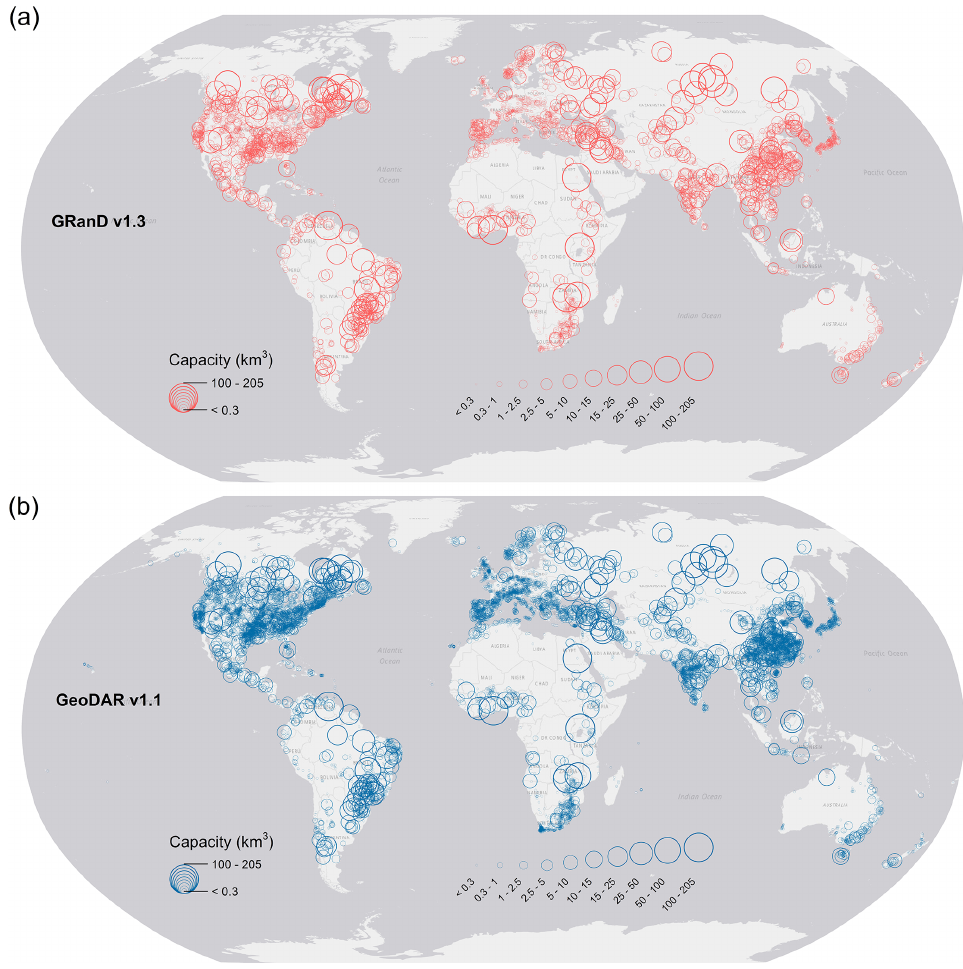
Figure 12. Global distribution of reservoir storage capacities of georeferenced dams. (a) GRanD v1.3 and (b) GeoDAR v1.1. Displayed are 7312 out of the 7320 dams in GRanD v1.3 and 24174 out of the 24783 dams in GeoDAR v1.1 with documented or estimated reservoir storage